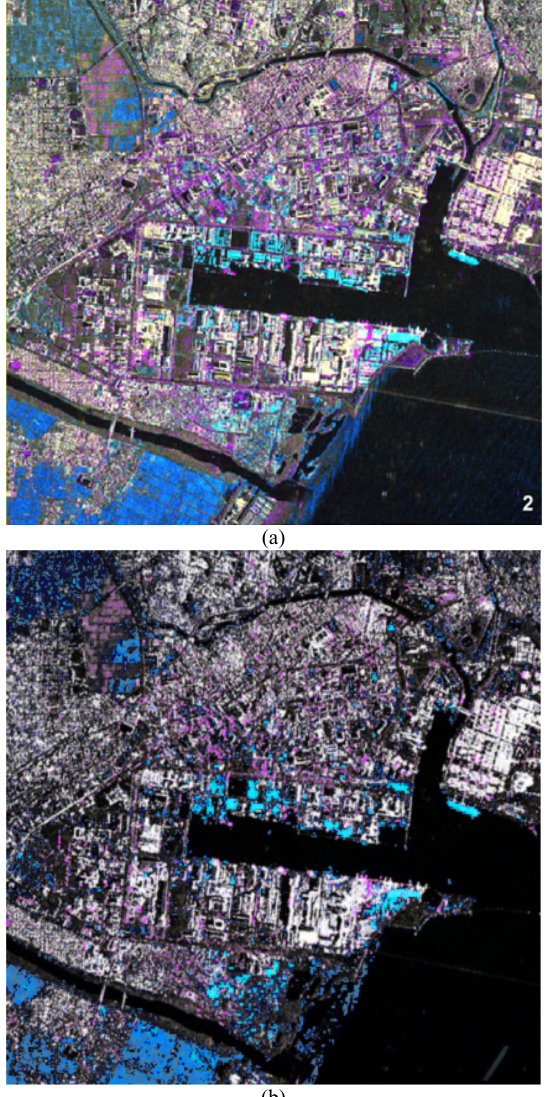
(b) Figure 3. (a) Cutout of the thematic map around Sendai harbor. (Magenta: deposited debris due to the tsunami; Bright blue: Tsunami-affected infrastructure; Dark blue: flooded area) (b) Cutout of false-color image with the same range and same color meanings as (a).